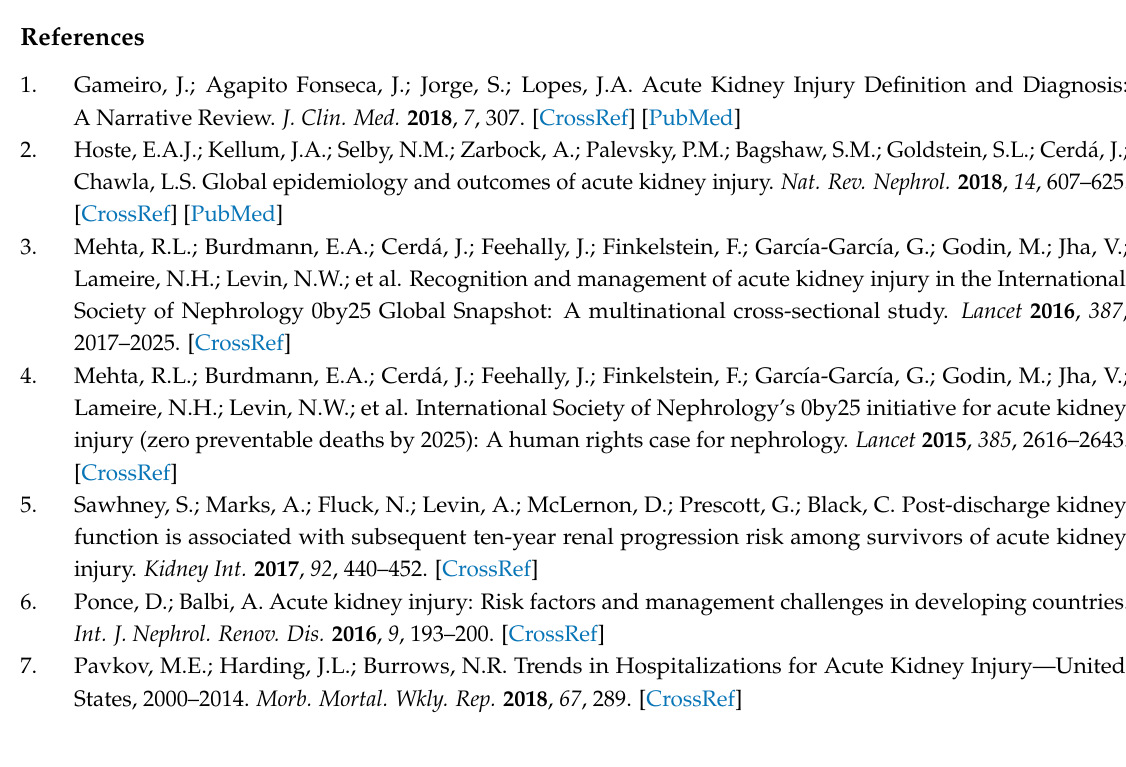
Figure S1: Funnel plot evaluating for publication bias evaluating incidence of post-LTx